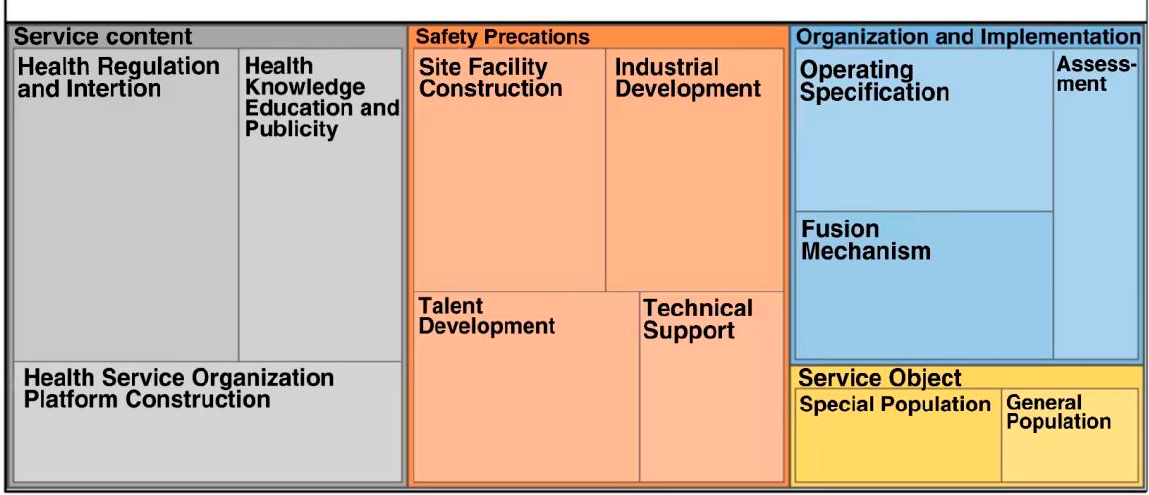
Figure 1. Policy and practice distribution map of the sports and medical integration service.